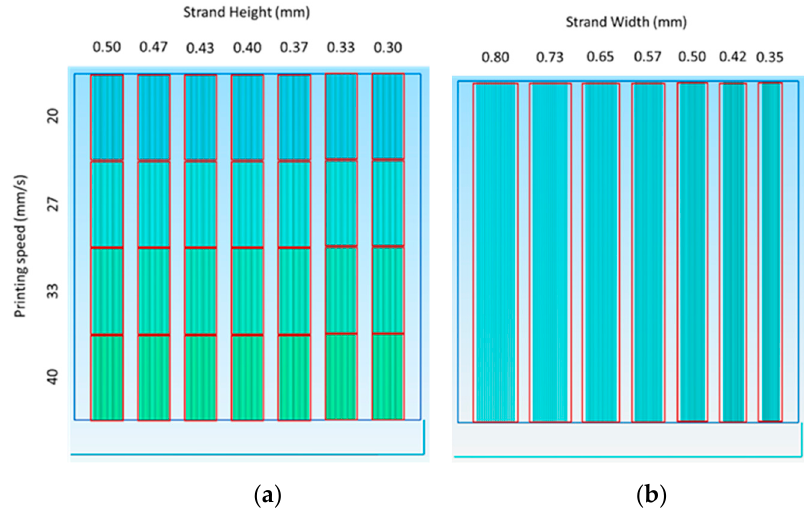
Figure 3. Display of the printing tests: ( a ) The first test with 28 variants of printing speed vs. thermoplastic strand height; ( b ) The second test with 7 values of strand width .